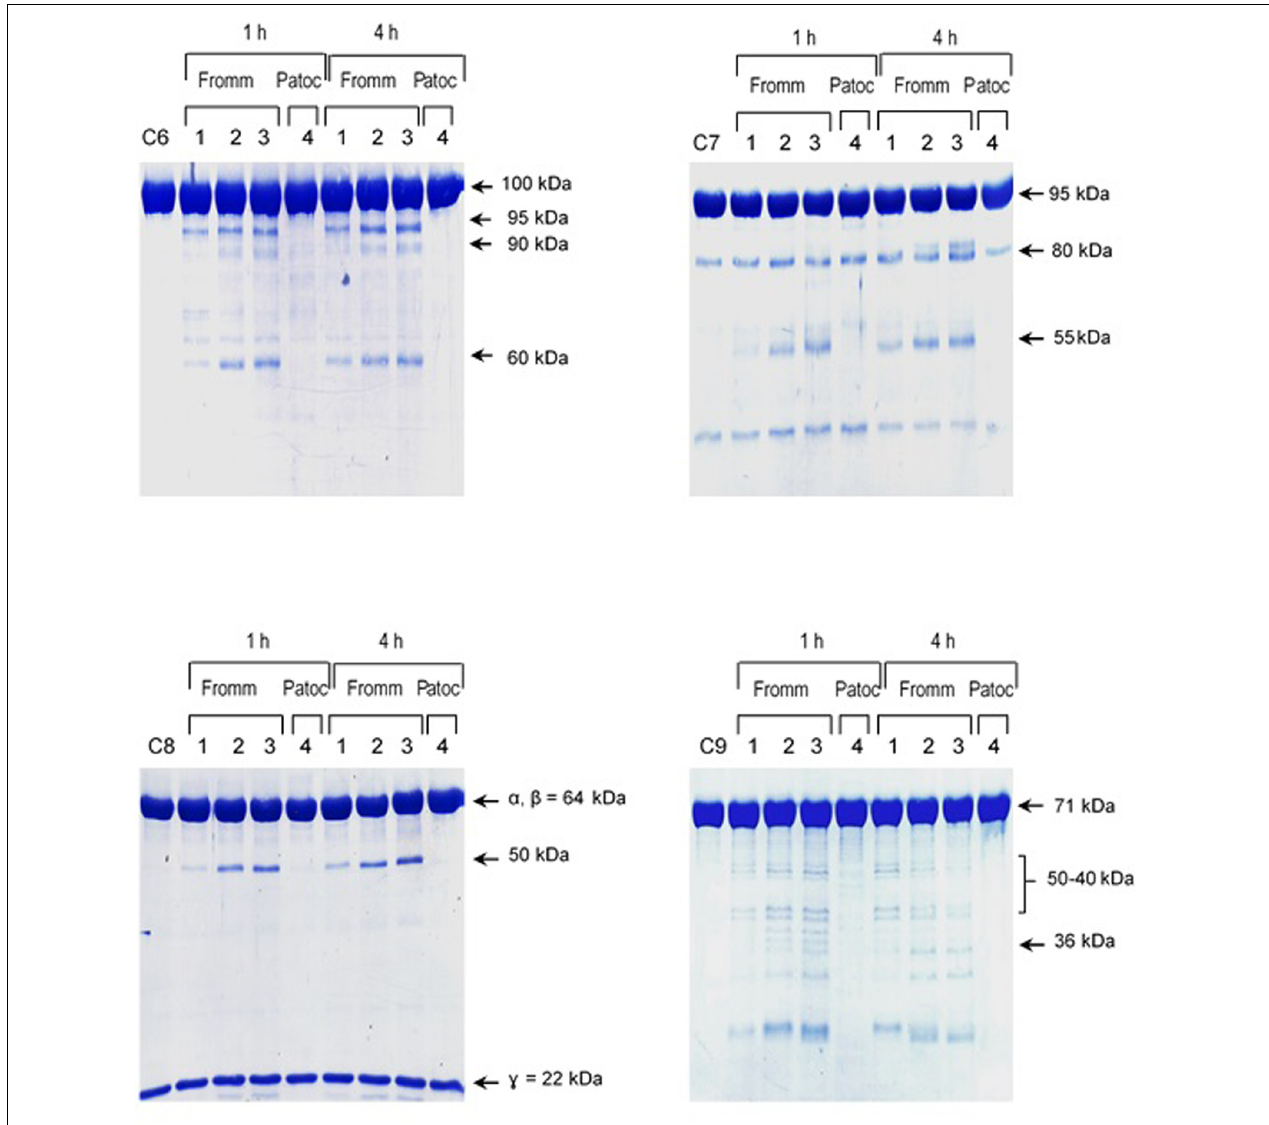
FIGURE 4 | Reduced amounts of leptospiral proteases are able to cleave components of the Membrane Attack Complex. Pathogenic L. interrogans serovar Kennewicki strain Fromm and saprophytic L. biflexa serovar Patoc strain Patoc I (1.0 × 10 9 bacteria) were allowed to secrete proteases for 4 h at 37 ◦ C. Different quantities of the supernatants, (1) 0.07 µ g, (2) 0.4 µ g, (3 and 4) 0.9 µ g were incubated with 5 µ g of the Complement proteins C6, C7, C8, or C9 (corresponding to 1/70; 1:15 and 1:5 w/w supernatant/Complement protein), for 1 h and 4 h at 37 ◦ C. The cleavages were analyzed by SDS-PAGE stained with Coomassie